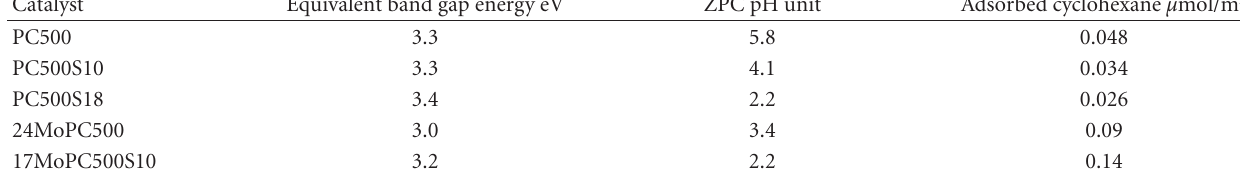
Table 2: Equivalent band gap energy, ZPC values, and amount of adsorbed cyclohexane in dark conditions for all catalysts.